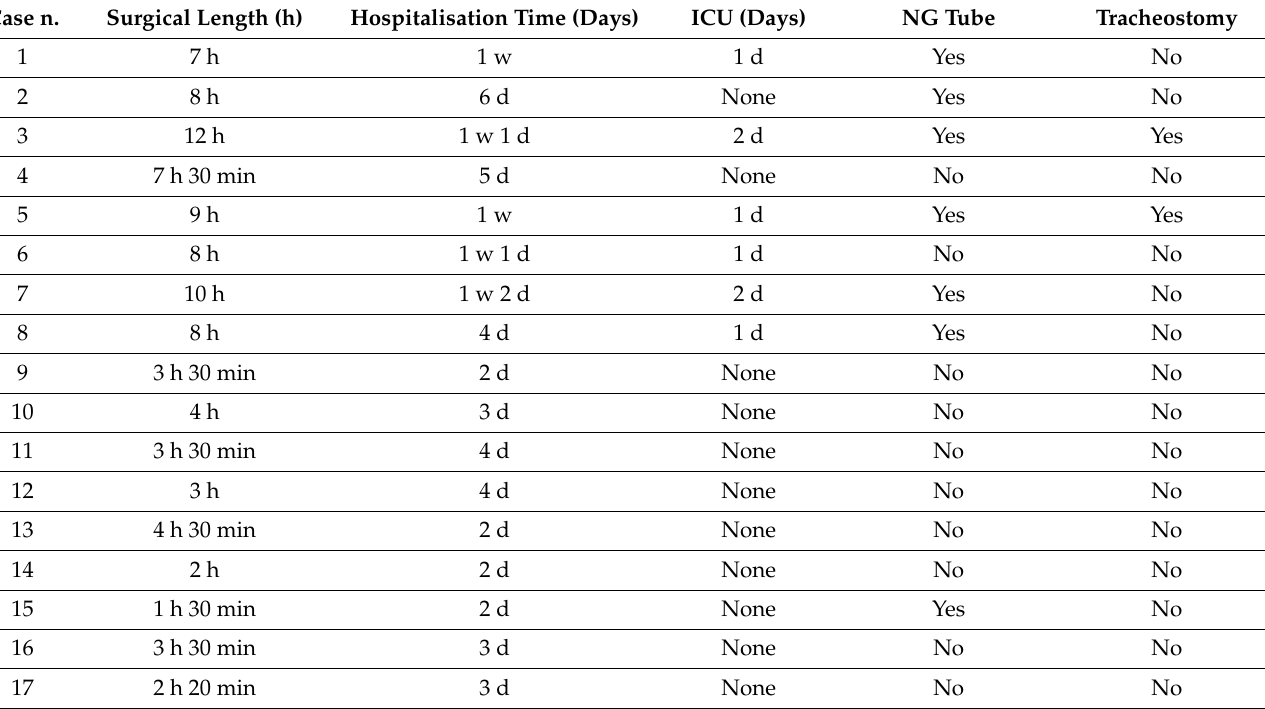
Table 3. Resume of post-operative progress (surgical length, ICU stay, NG tube, and tracheostomy). Case